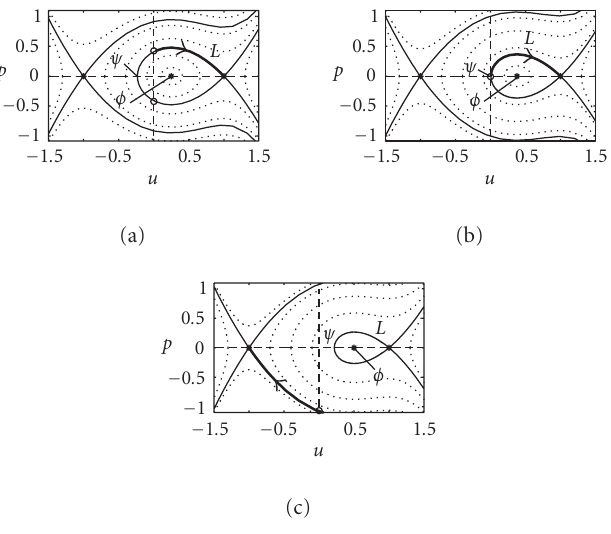
Figure 3.1. Bold solid lines represent phase trajectories corresponding to the boundary layer transi- tions near the left boundary point x =